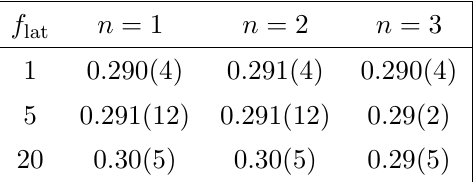
Table 4 . R ( (cid:17) c ) as a function of the truncation power n of coe(cid:14)cients included from eq. (5.10) and the systematic lattice uncertainty f lat .